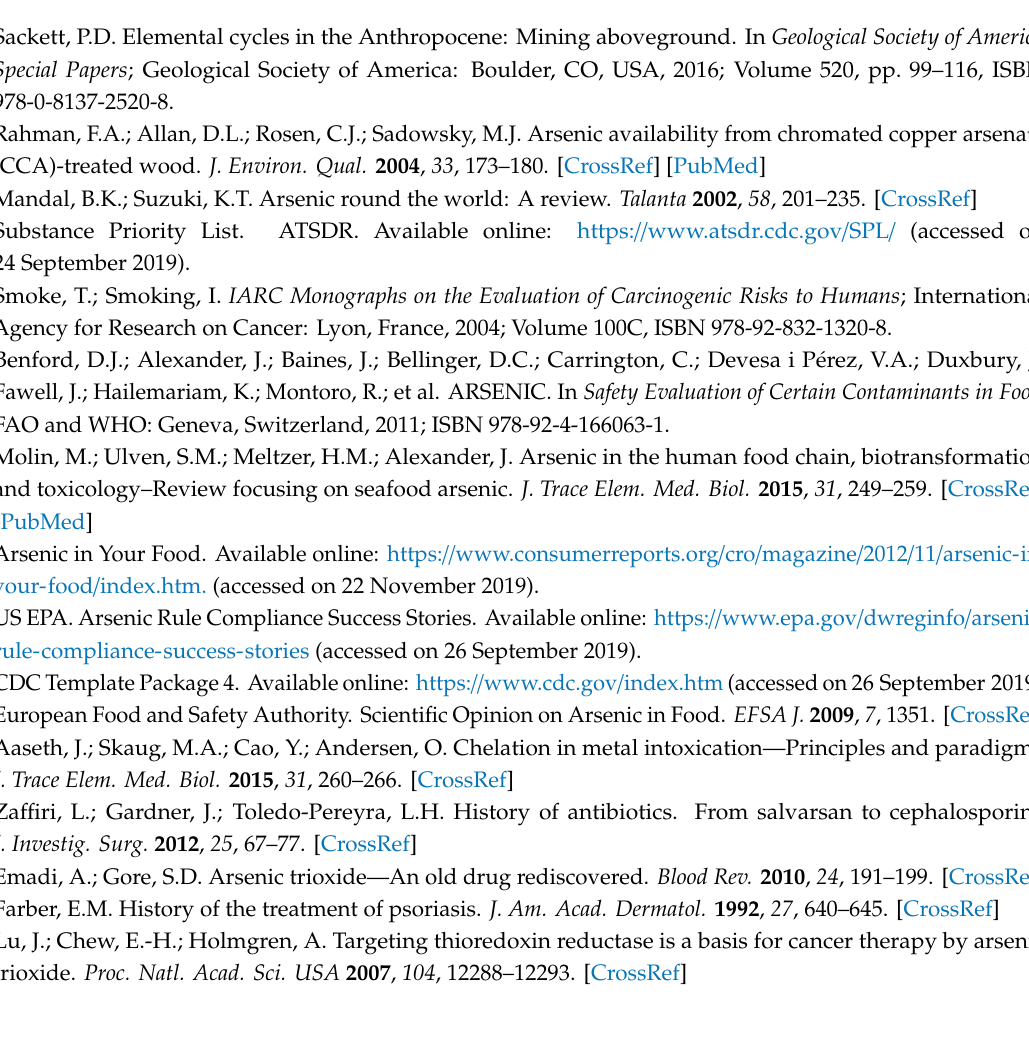
Figure S1. Molecular formulae of the 1:1 adducts proposed in reference [114] based on NMR results formed between A) trans -2-chlorovinylarsine oxide or lewisite oxide (LO) and DHLA; B) LO and DMSA; C) LO and DMPS; D) PDA and DMSA; E) PDA and DMPS, Table S1. Structures of As(III) with di ff erent ligands bearing mercapto groups, where hydrogen is shown in light grey, carbon in grey, nitrogen in blue, sulfur in yellow, oxygen in red, and As(III) in violet. The coordinates were obtained from the Cambridge Structural Database, and the image was created using